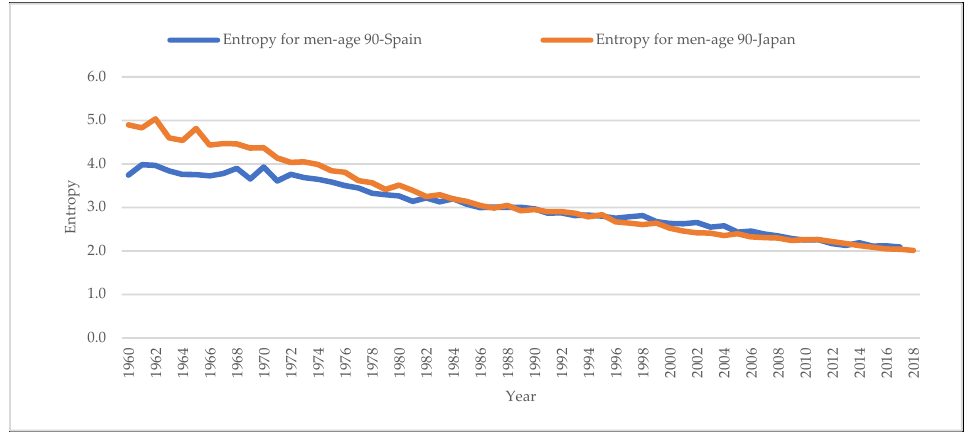
Figure 9. Entropy evolution for the male population at 90 over calendar years. Source: authors.